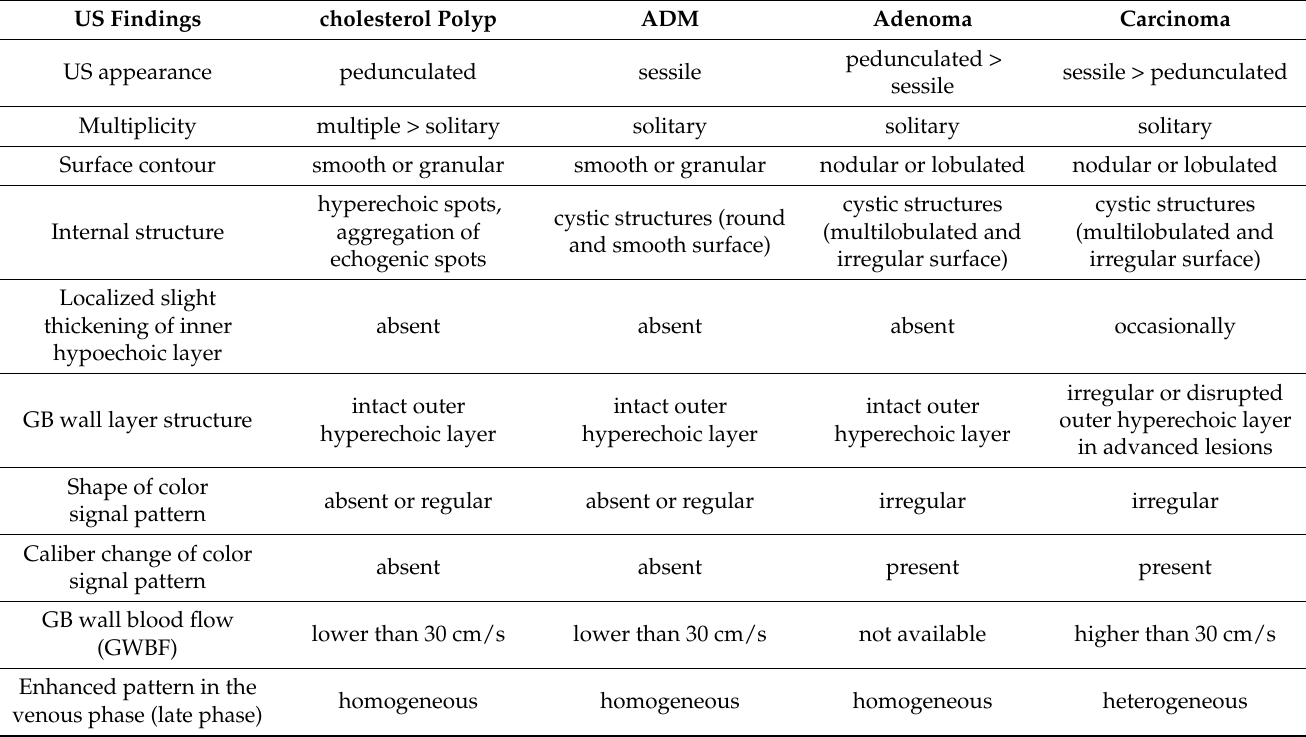
Table 1. US findings in major